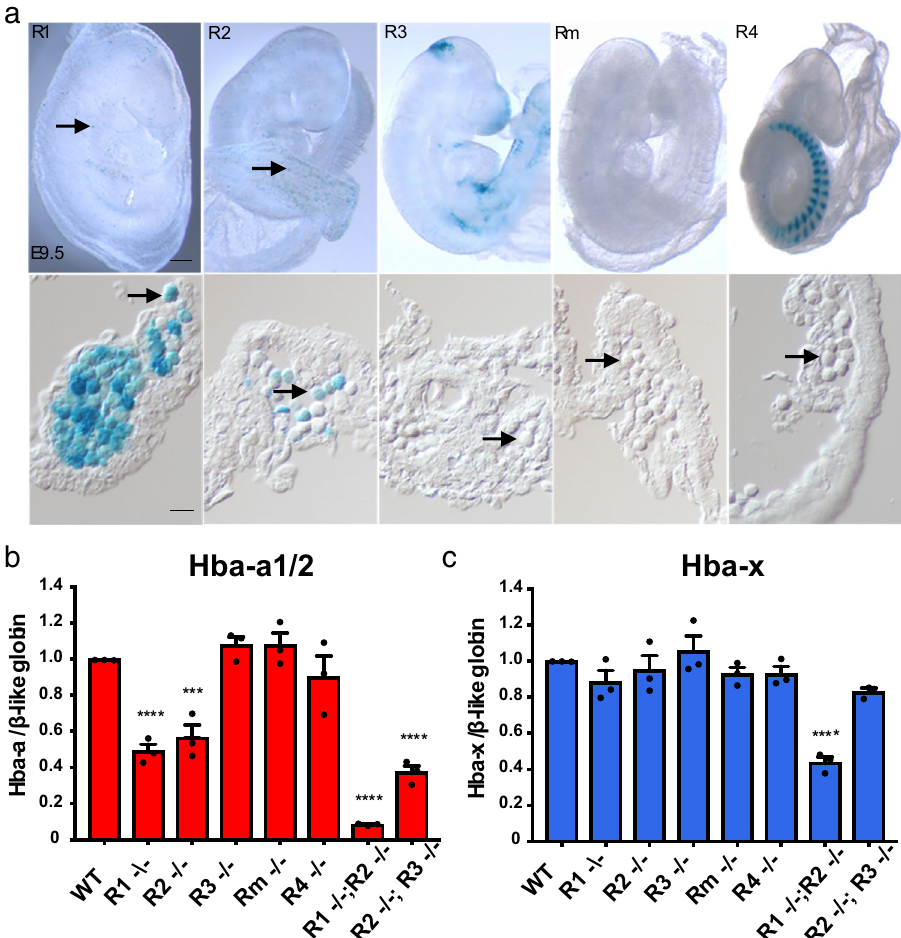
Fig. 2 Functional analysis and contribution of each enhancer in primitive erythroblasts. a Representative LacZ-stained transgenic E9.5 embryo for each of the enhancer constructs (upper) and sections through the yolk sac with a population of hematopoietic cells (lower). R1 and R2 show activity in the majority of erythroid cells; there is no detectable activity in these cells from R3, R4, or the Rm element. Arrows indicate yolk sac blood islands in the upper panels and individual erythroblasts in the lower panels. Scale bar represents 250 μ m in the upper panels and 25 μ m in the lower panels. Numbers of positively stained embryos are summarized in Supplementary Table 2. b , c NanoString quanti fi cation of the ratio of Hba-a1/2 ( b ) and Hba-x ( c ) to β -like globin transcripts (comprising Hbb-b1, Hbb-bh1, Hbb-bh2, Hbb-y) from steady-state RNA isolated from primitive erythroblasts isolated from homozygote mice at E10.5; mutant samples are normalized to wild-type. N = 3 biologically independent samples. Data are presented as mean ± SEM. A signi fi cant reduction in the α -globin: β -globin-like transcript ratio is observed in R1 − / − , R2 − / − and the R2 − / − ; R3 − / − double-knockout embryos in comparison to wild- type. A 90% reduction in the ratio is seen in the R1 − / − ; R2 − / − double-knockout embryos. The ζ -globin: β -globin-like transcript ratio is only signi fi cantly reduced (by 60%) in the R1 − / − ; R2 − / − double-knockout embryos. *** denotes p ≤ 0.001; **** denotes p ≤ 0.0001; statistical signi fi cance was calculated using a one-way ANOVA with Dunnett correction for multiple comparisons. Source data are provided as a Source Data fi